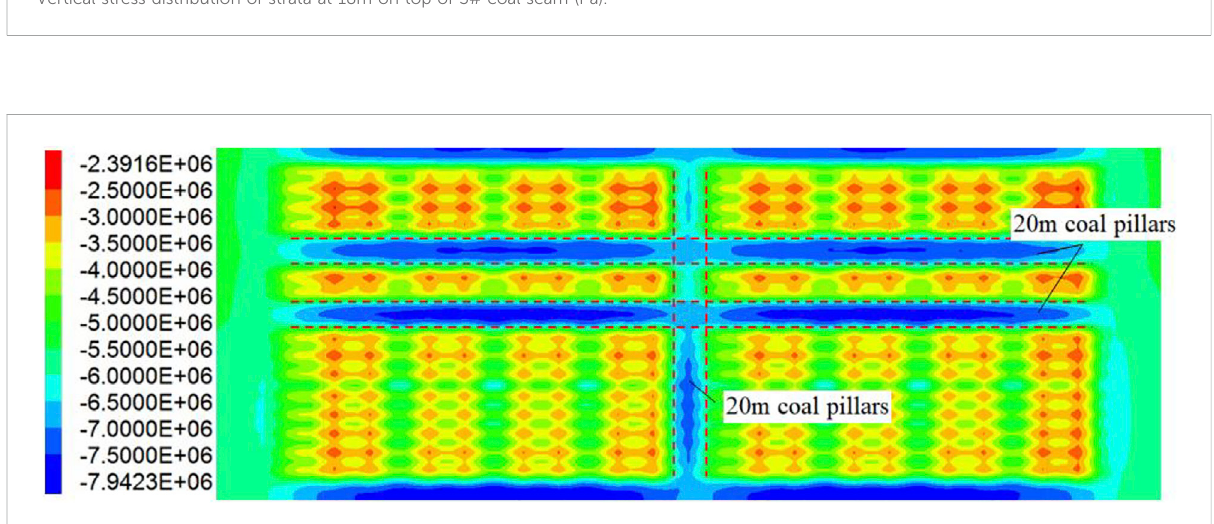
FIGURE 17 Vertical stress distribution of strata at 20m on top of 3# coal seam (Pa).